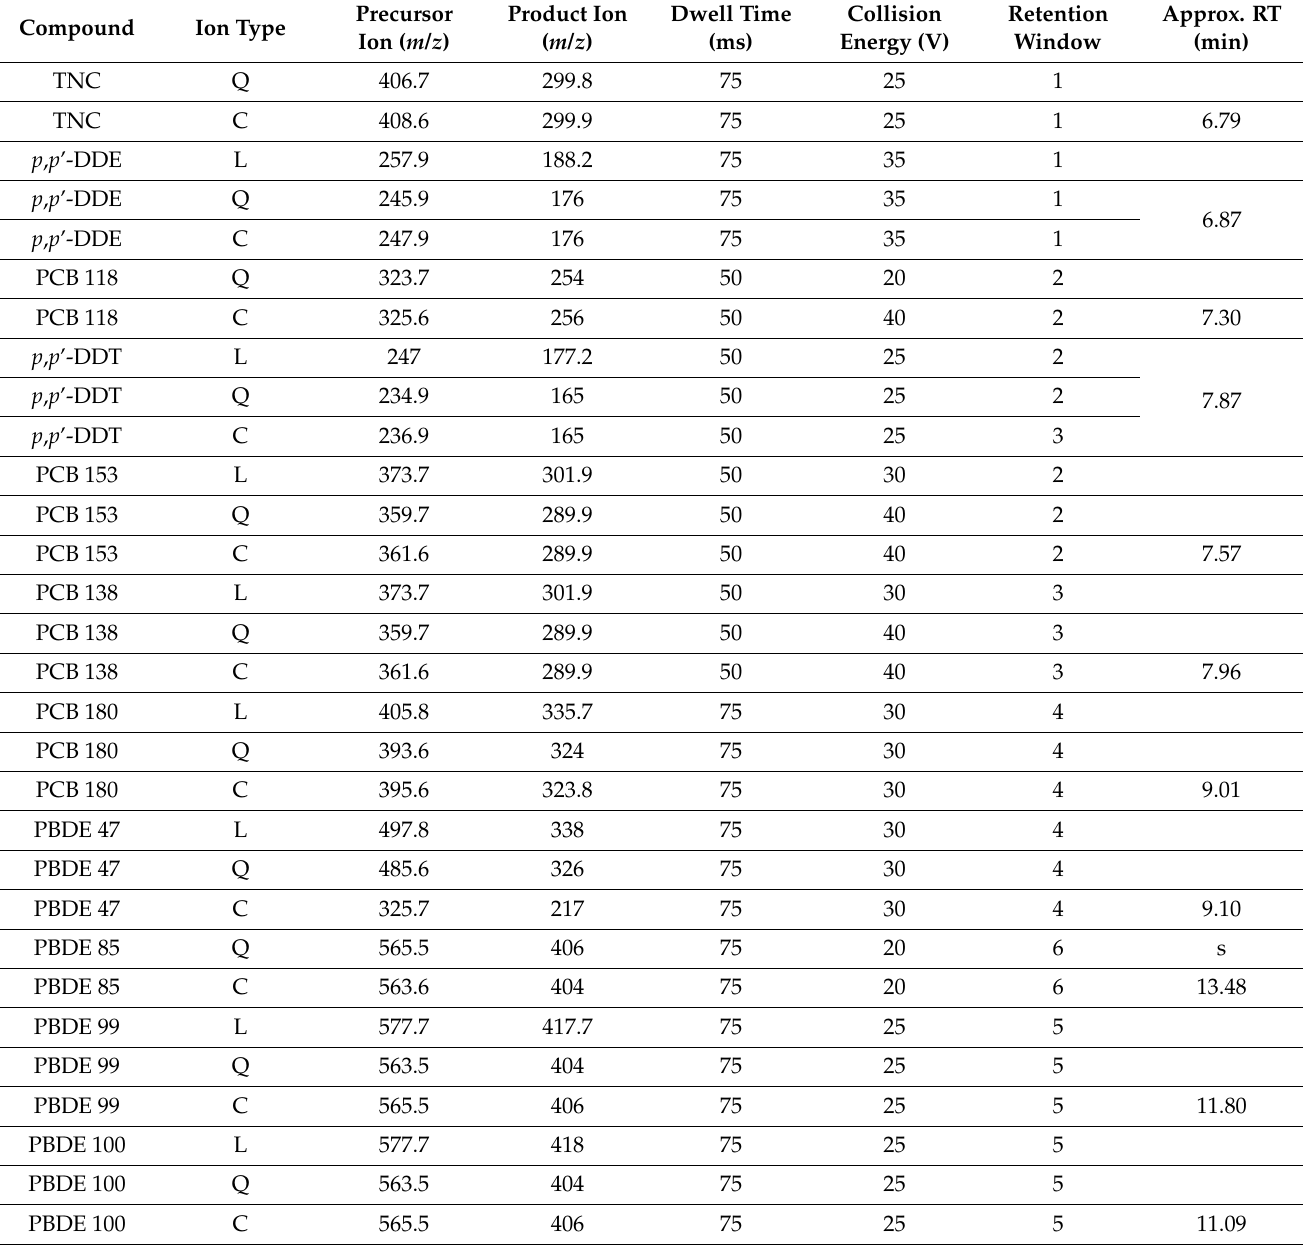
Table 1. MRM transitions and related parameters by target